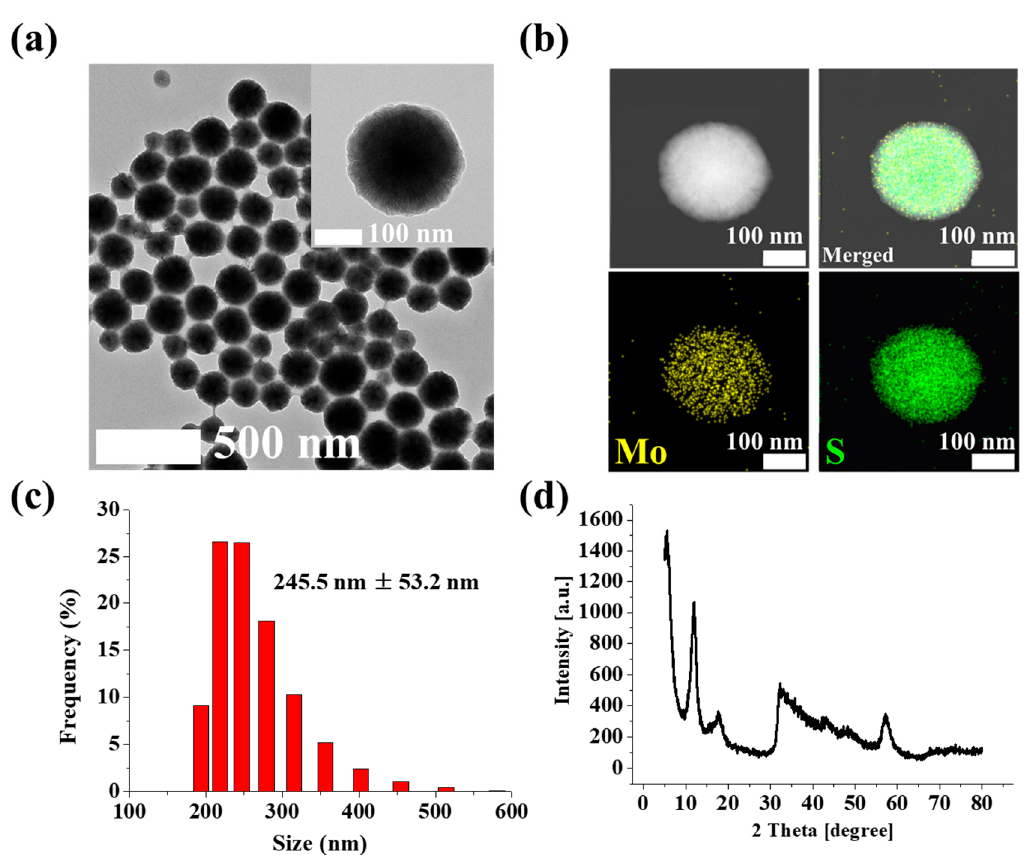
Figure 2. ( a ) TEM and ( b ) energy-dispersive X-ray spectroscopy (EDS) mapping images of MoS 2 nanoparticles (NPs), ( c ) dynamic light scattering (DLS) result of MoS 2 NPs, and ( d ) XRD pattern analysis of MoS 2 NPs.